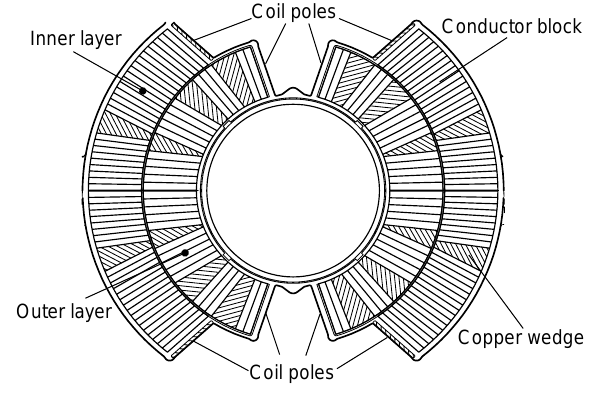
FIG. 2. Cross section of the LHC dipole coil.